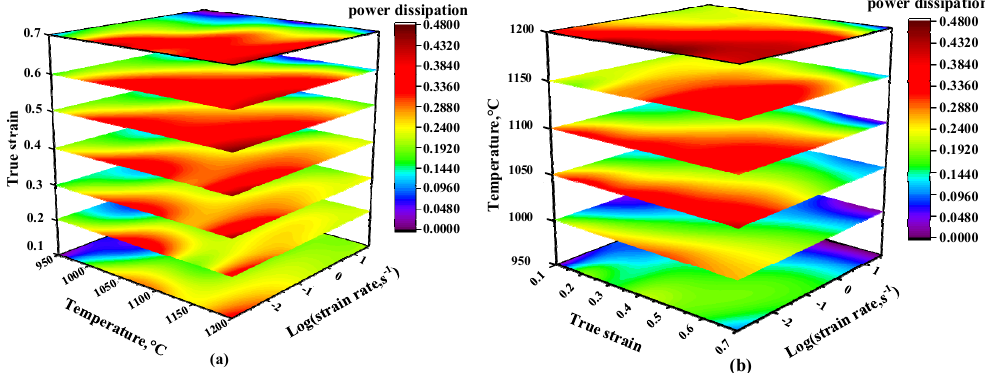
Figure 9. Three-dimensional power dissipation maps at various conditions: ( a ) Three-dimensional power dissipation map at strain ranges of 0.1–0.7 ; ( b ) The 3-D power dissipation map at 950–1200 °C.